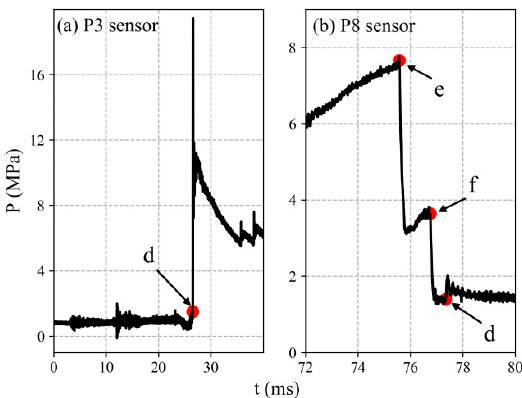
Figure 3. Pressure periods in the pump tube during the piston movement passing through the sensor. ( a ) P3 sensor; ( b ) P8 sensor. ( a ) P3 sensor; ( b ) P8